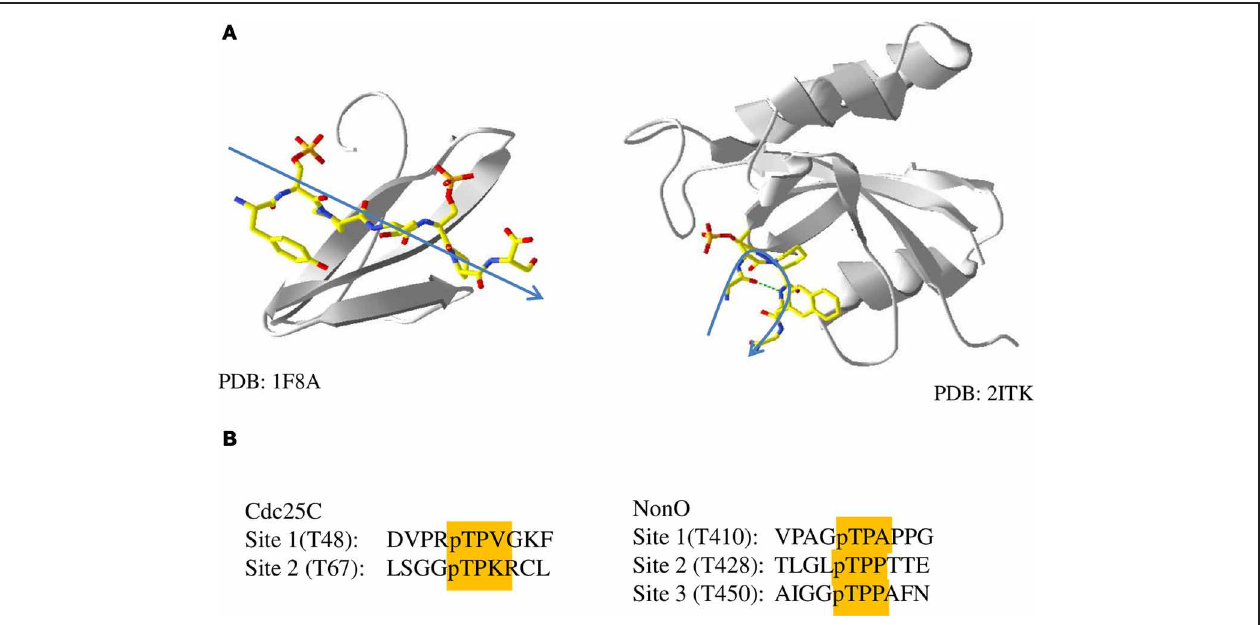
FIGURE 5 | Phosphopeptide binding by the WW and PPIase domains. (A) Structures of the WW domain (left, 1F8A) and PPIase domain (right, 2ITK) of Pin1 bound to peptides or peptide inhibitors. A general trace of the